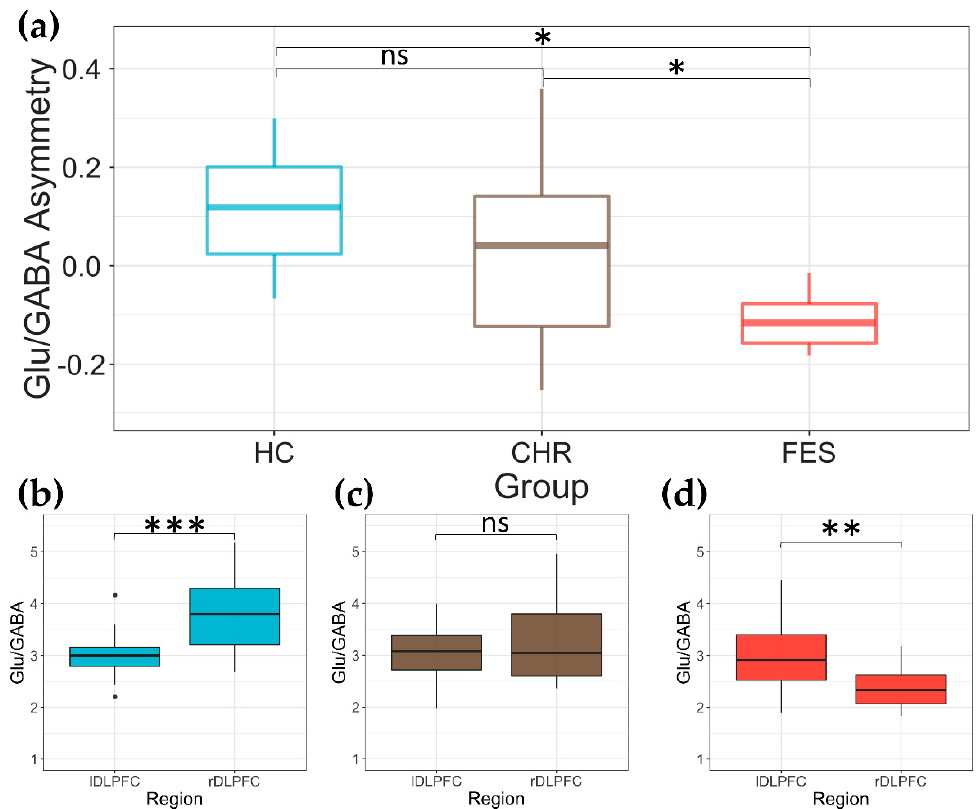
Figure 2. ( a ) The Glu/GABA asymmetry measure among the 3 study groups was computed as the difference between right and left DLPFC Glu/GABA over their summation. Box plots displaying the comparison between rDLPFC and lDLPFC Glu/GABA ratio in healthy control (HC, ( b )), clinical high risk (CHR, ( c )), and first episode schizophrenia (FES, ( d )). We also computed paired t -test rDLPFC and lDLPFC Glu/GABA comparisons among groups; ns represents non-significant differences, * p < 0.05, ** p < 0.01, and *** p < 0.001.